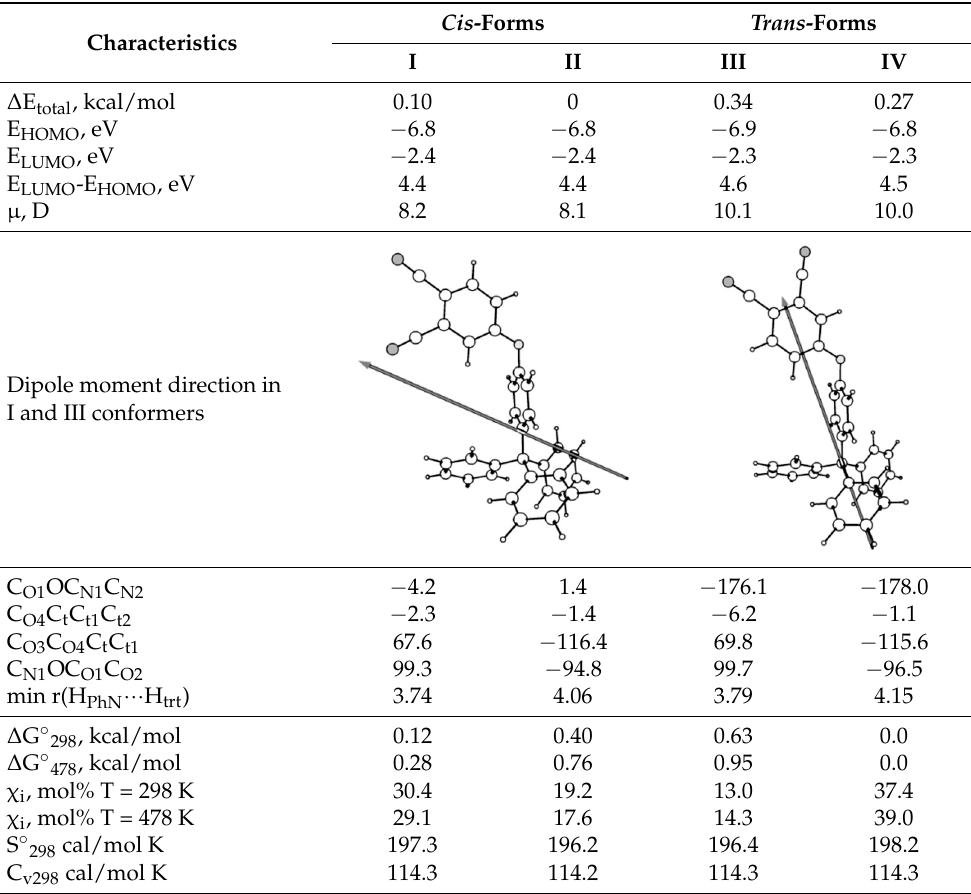
Table 1. Selected characteristics of 4-(4-tritylphenoxy)phthalonitrile conformers according to